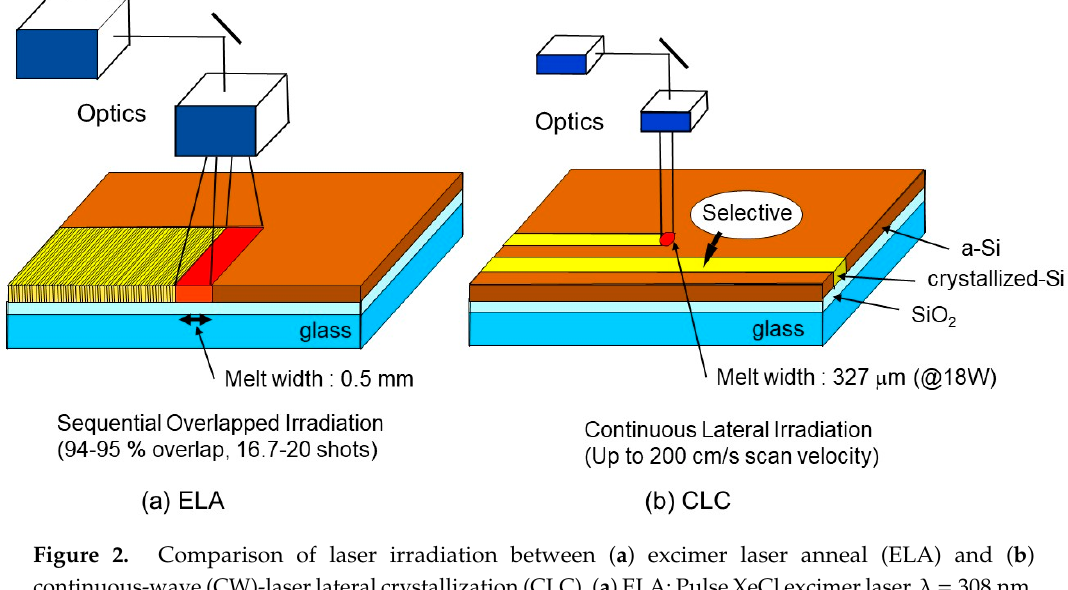
Figure 2. Comparison of laser irradiation between ( a ) excimer laser anneal (ELA) and ( b ) continuous-wave (CW)-laser lateral crystallization (CLC). ( a ) ELA: Pulse XeCl excimer laser, λ = 308 nm, and power fluctuation ~ ± 10%. ( b ) CLC: CW laser (diode-pumped solid-state (DPSS)), λ = 532 nm, and power fluctuation < ±1%.